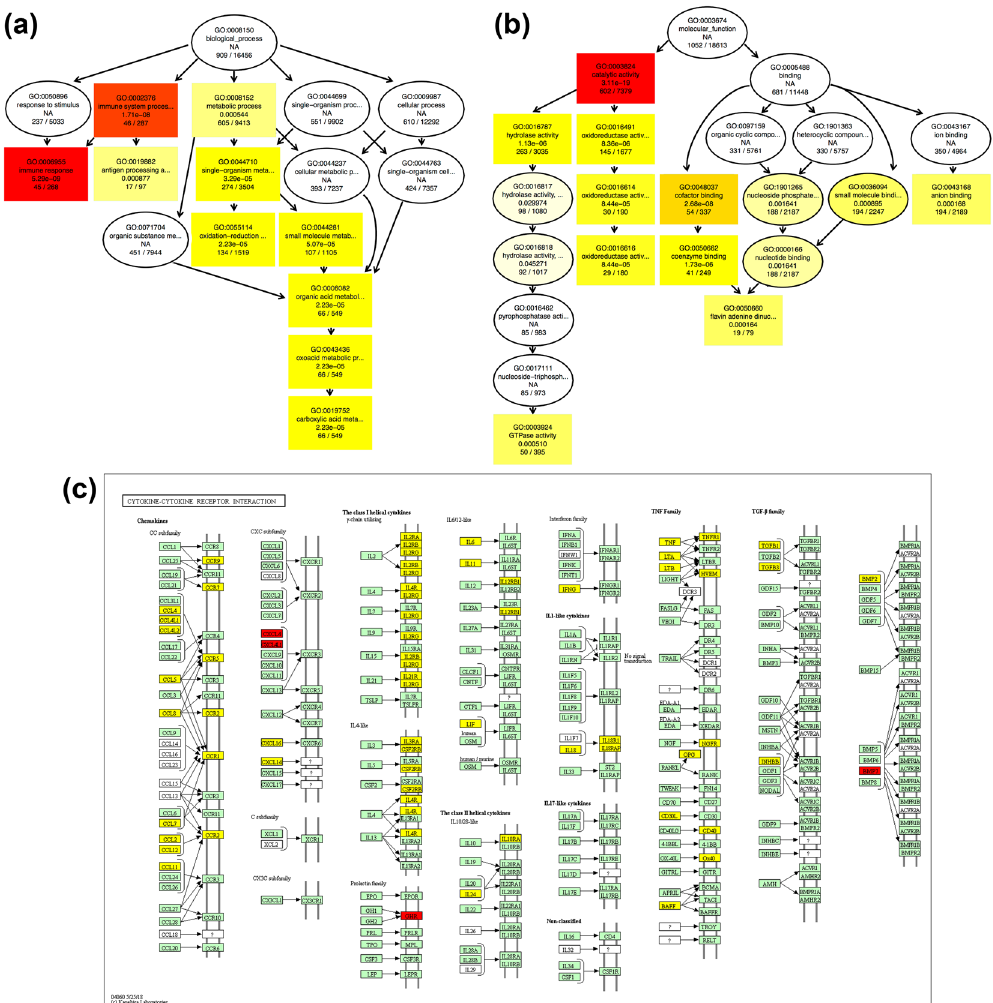
Figure 5. Directed acyclic graph (DAG) of the 10 most enriched Gene Ontology (GO) terms and cytokine– cytokine receptor interaction pathways based on KEGG analysis. pCAG-APE1- and pCAG-EGFP-injected unilateral obstructed ureter (UUO) kidneys were compared for differentially-expressed genes. The DAG shows the topological relationships among the 10 most enriched GO terms. Circles and boxes with different colors represent enriched GO terms for biological process and molecular function categories. Every node indicates one GO term; boxes represent the top 10 enriched GO terms and the P value of the enrichment analysis. The enrichment degree is illustrated by color shades, with the darker the shade, the higher the enrichment. ( a ) The DAG of the 10 most enriched GO terms in the biological process category. Note that immune response was the most enriched GO term among biological processes. ( b ) The DAG of the 10 most enriched terms for molecular function. Note that catalytic activity was the most enriched GO term among molecular functions. ( c ) Cytokine– cytokine receptor interaction pathways based on KEGG analysis (KEG map04060) 11–13 . Yellow rectangles represent down-regulated genes, whereas red rectangles represent up-regulated genes after pCAG-APE1 injection. Copyright permission of this KEGG pathway map was kindly provided by the Kanehisa